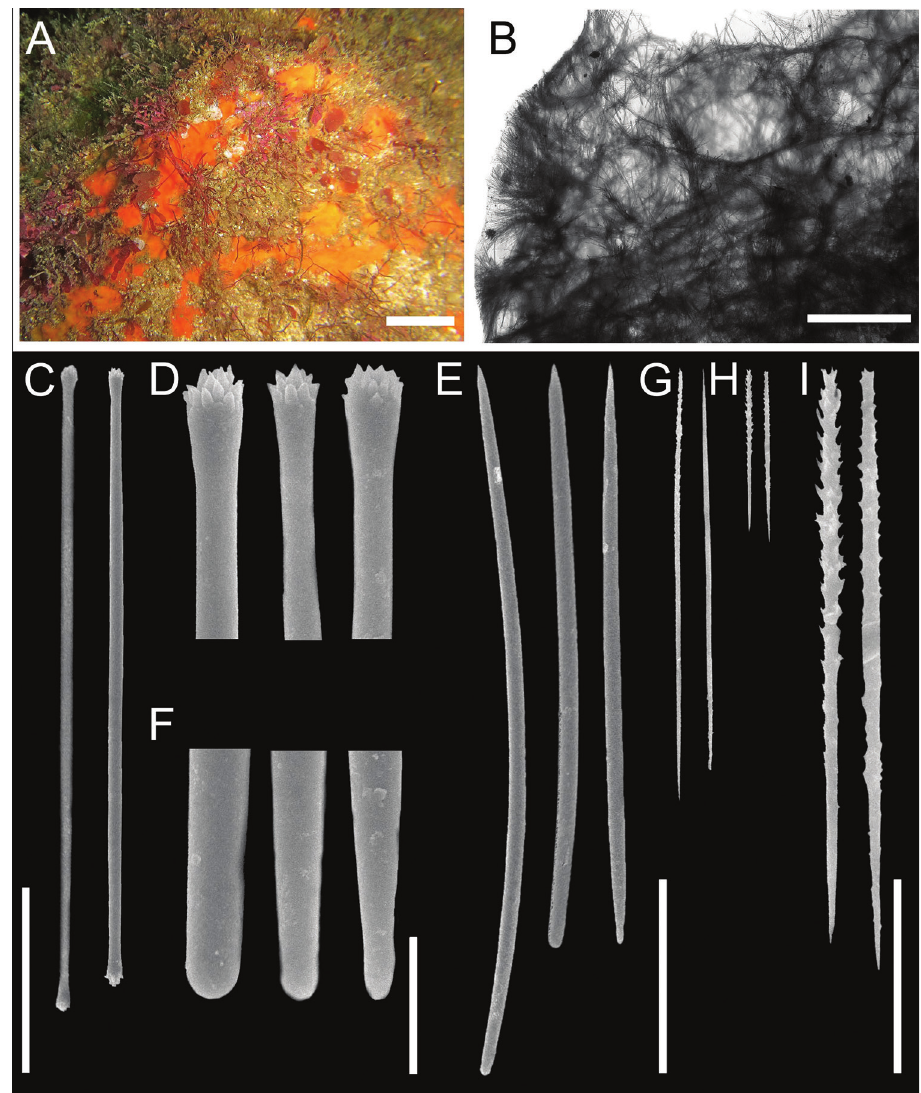
Figure 2. Tedania ( Tedania ) ecuadoriensis sp. nov. A holotype in situ (CENAIM 150813EP01-05) B transverse section of ectosomal and choanosomal skeletal architecture C ectosomal tylotes D detail of terminally microspined terminations of ectosomal tylotes E choanosomal styles F detail of the bases of choanosomal styles G large onychaetes h–i small onychaetes. Scale-bars: 2 cm ( A ); 500 µm ( B ); 50 µm ( C, E, G–h ); 10 µm ( D, F, i